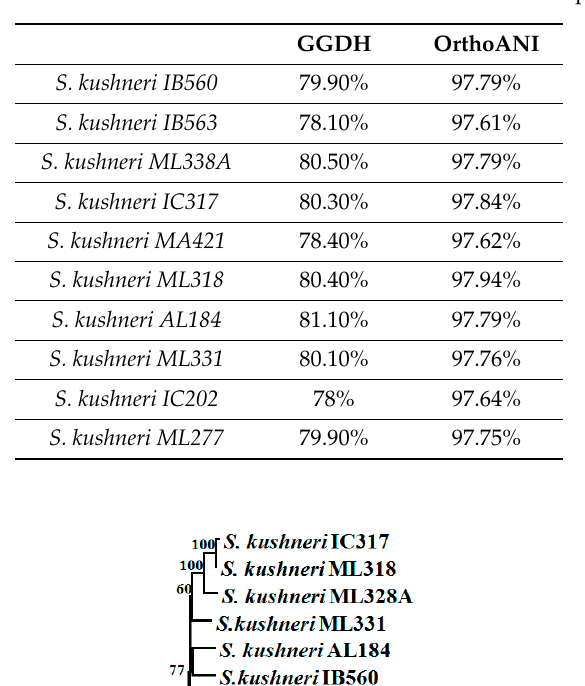
Table 1. In silico Genome-to-Genome Hybridization (GGDH), and OrhtoANI values of Salinivibrio sp. HTSP with 10 other strains of Salinivibrio kushneri isolated from the salterns in Spain [34].